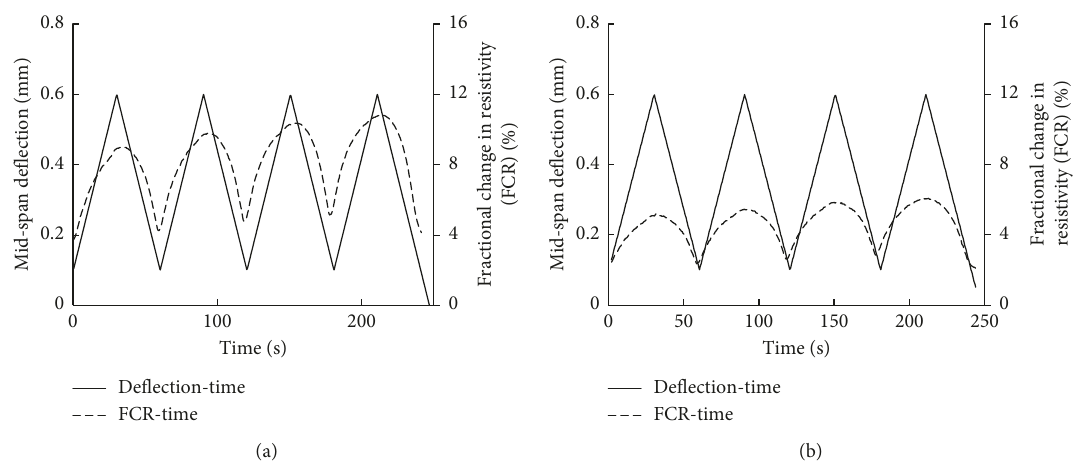
Figure 11: Effect of dosage of MWCNTs on the self-sensing ability: (a) 0.5% MWCNT and (b) 0.7%